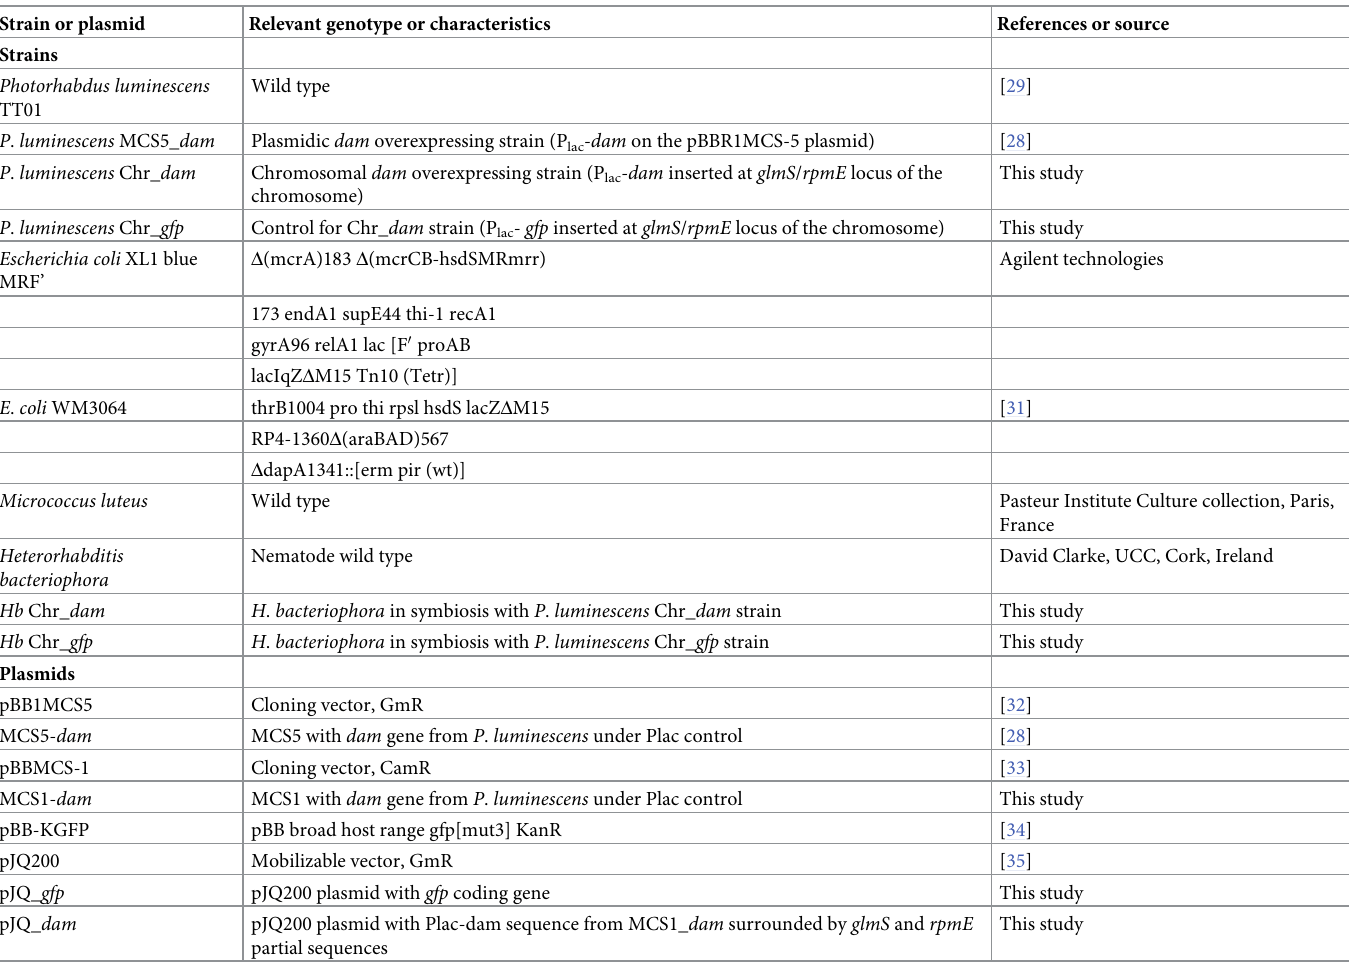
Table 1. Strains and plasmids used in this